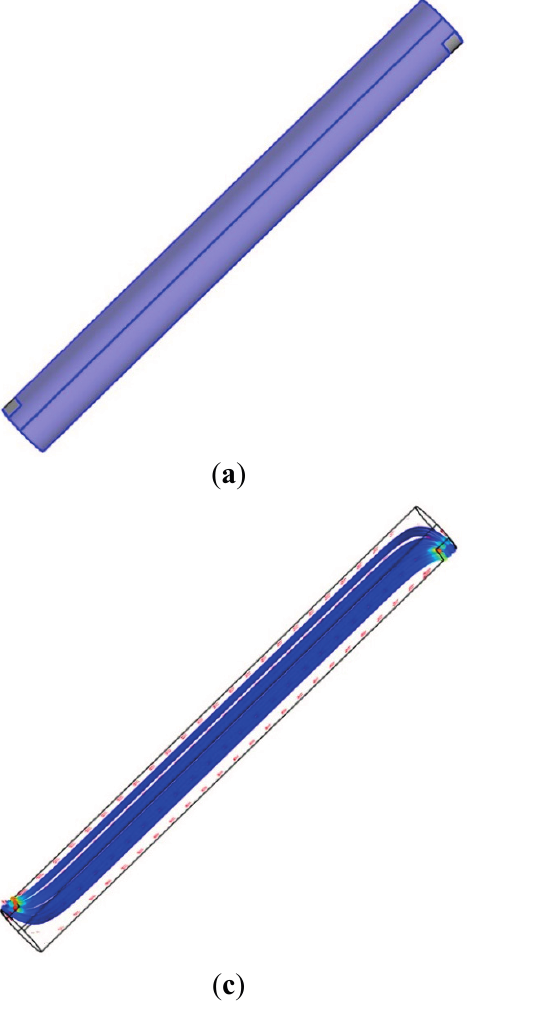
Figure 4. Simulation with single cylindrical pipe structure: ( a ) physical structure (pipe dimension: l = 117.7 mm and d = 10 mm; window dimension: h = 3 mm and w = 8 mm); ( b ) sound pressure distribution at 1033.6 Hz; ( c ) root mean square (RMS) sound intensity streamline at 1033.6 Hz; and ( d ) RMS sound intensity streamline at 22,007